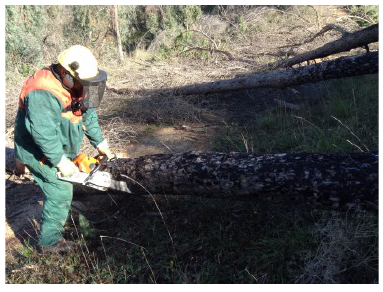
Figure 3. Tree bucking task.